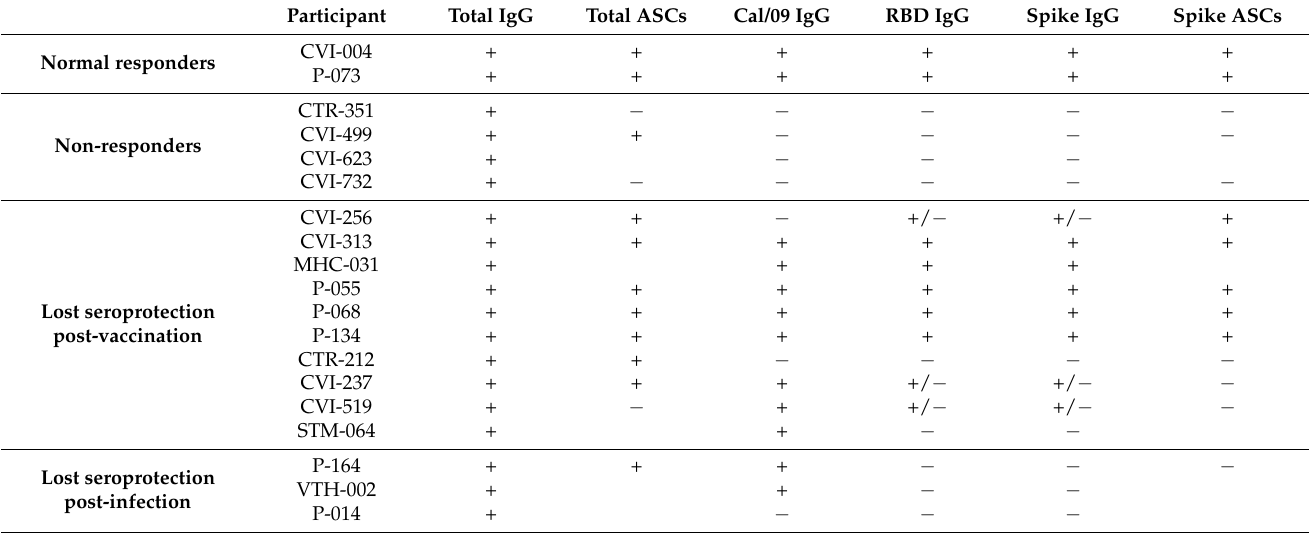
Table 1. Memory B cell recall response in participants who lost their seropositive status after vaccination or infection.